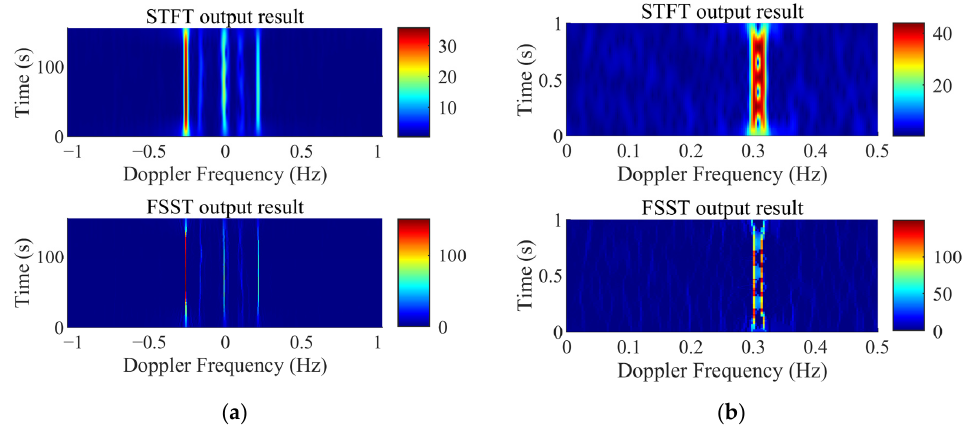
Figure 5. The time–frequency analysis of targets: ( a ) the analysis results of two real targets; ( b ) the analysis results of two closely spaced simulated targets.